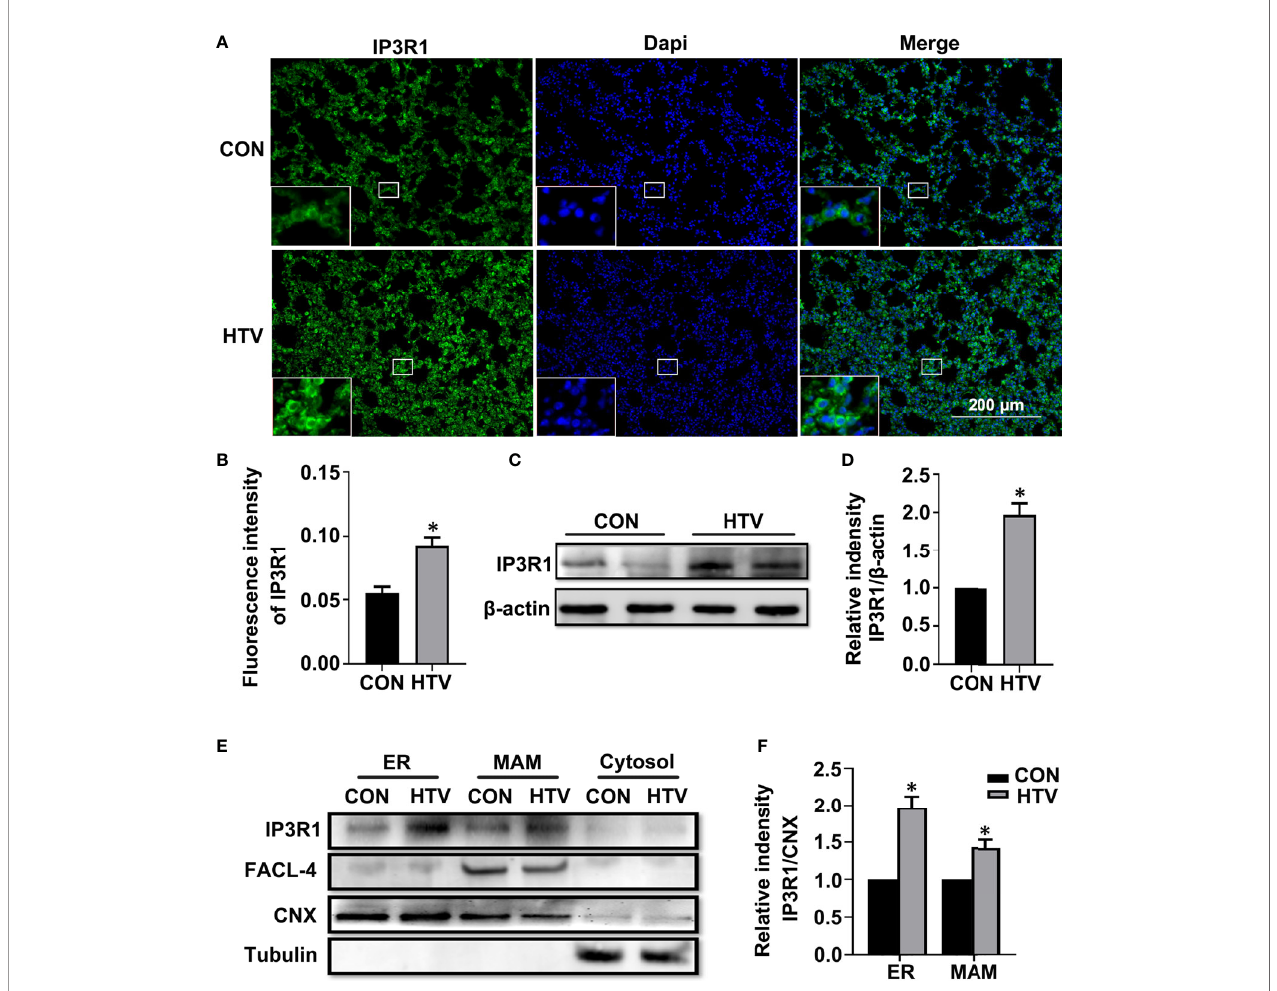
FIGURE 1 | MV with HTV induces IP3R1 activation in lungs. Immuno fl uorescence photomicrographs (A) and quanti fi cation analysis (B) of IP3R1 in lung tissues of mice with spontaneous breathing (CON group) or mechanical ventilation at high tidal volume (HTV group). Dapi (blue) was used to stain the nuclei. Scale bar: 200 m m. An inset picture was employed to show the indicated area at 4X magni fi cation. Western blot (C) and quanti fi cation analysis (D) of IP3R1 protein expression in lung extracts. (E) Western blot analysis of the indicated subcellular fractions for IP3R1, calnexin (CNX; ER and MAM marker), FACL-4 (MAM marker) and tubulin (cytosolic marker). (F) Quanti fi cation of IP3R1 protein expression in the ER and MAM was performed by normalizing to CNX. Data are expressed as means ± SD (n = 6 animals per group). * P < 0.05 vs . CON